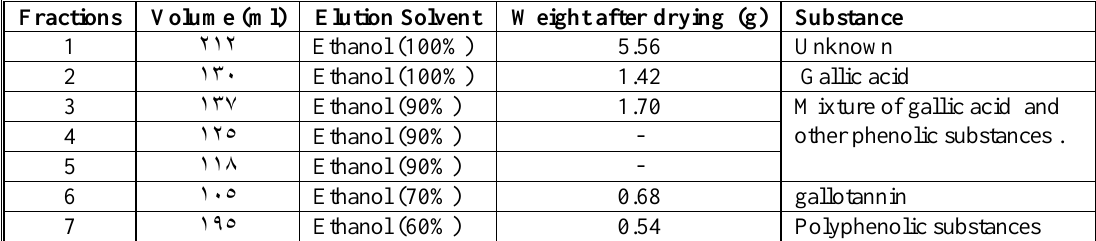
Table(2) : Fractionations of gallic acid and gallotannin by column chromatography